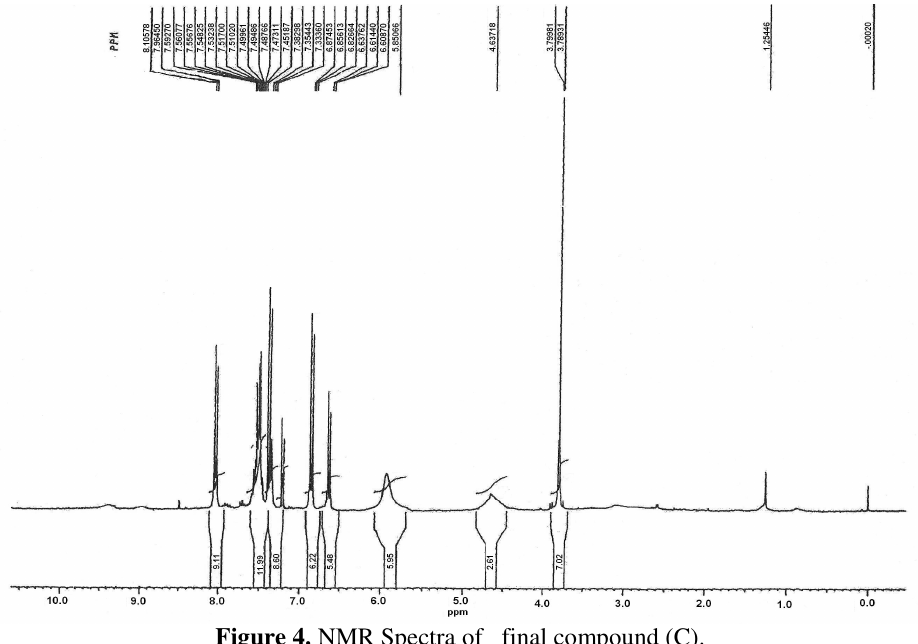
Figure 4. NMR Spectra of final compound